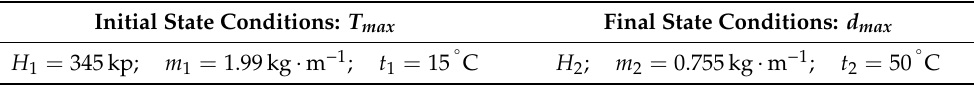
Table 2. Conditions for the cable RZ 3x50 Al / 54.6 Alm .